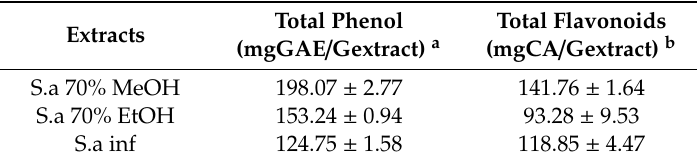
Table 1. Total phenol and flavonoid content of S. aramiensis extracts.